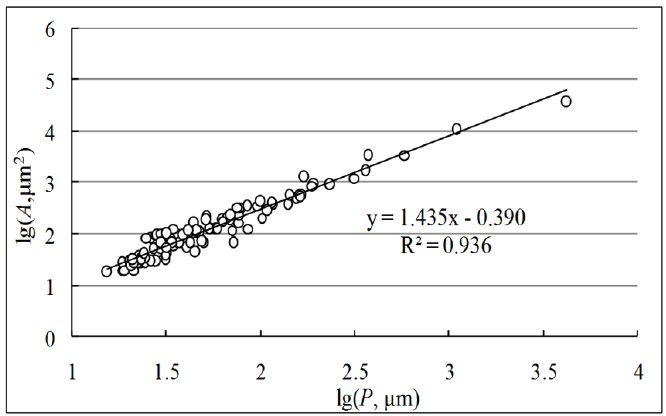
Figure 8. Relationship between the approximate perimeter and area of the